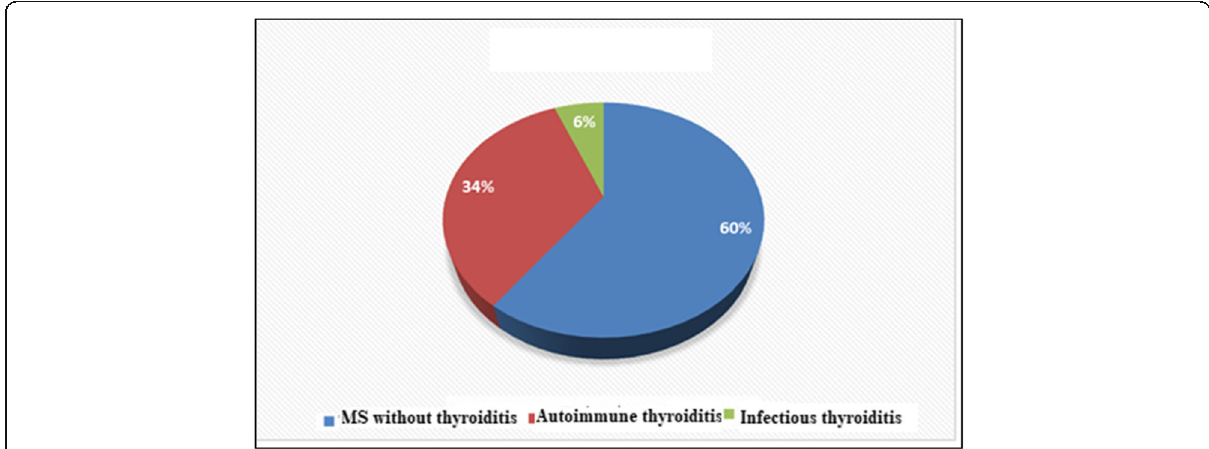
Fig. 1 The prevalence of thyroiditis among patients with multiple